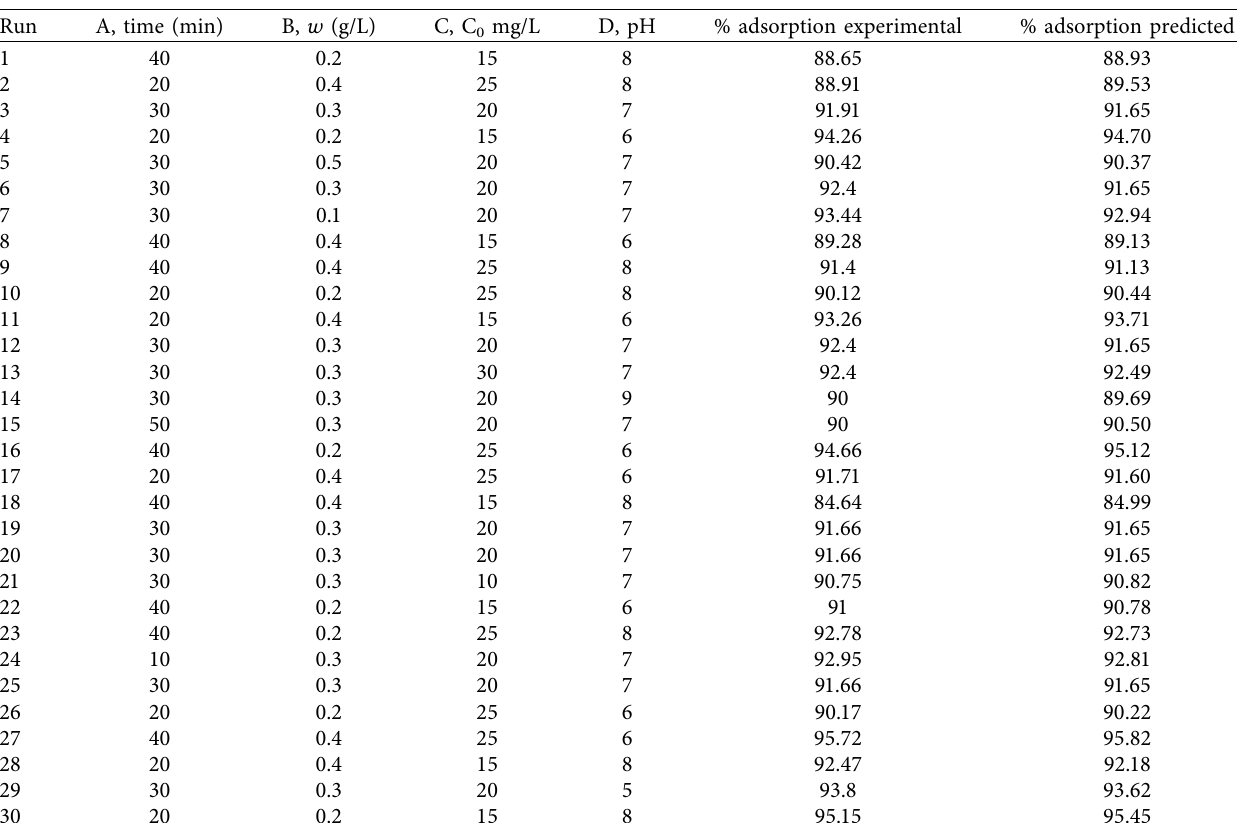
Table 2: Actual versus model predicted values for adsorption.